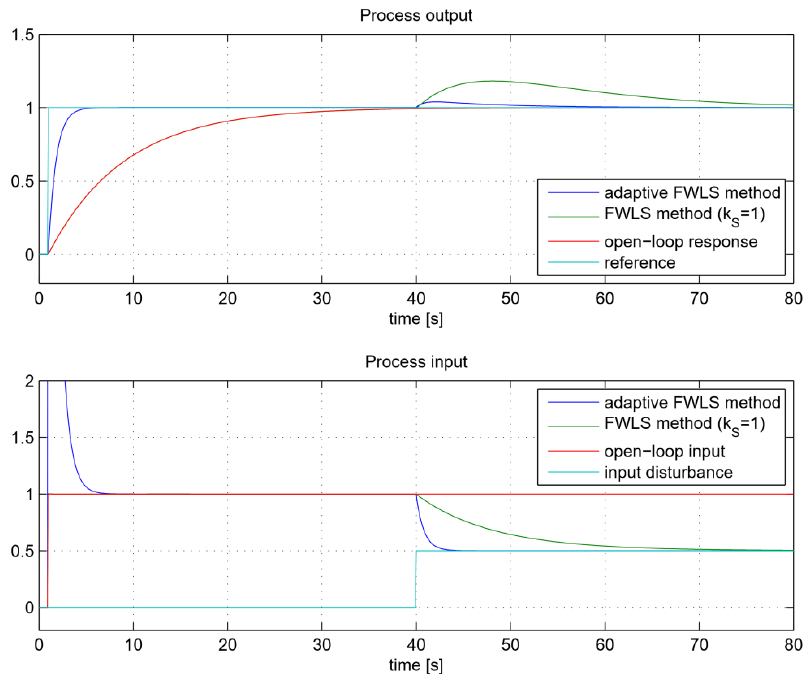
Figure 17. The closed-loop tracking and control signals for process G P 1 .